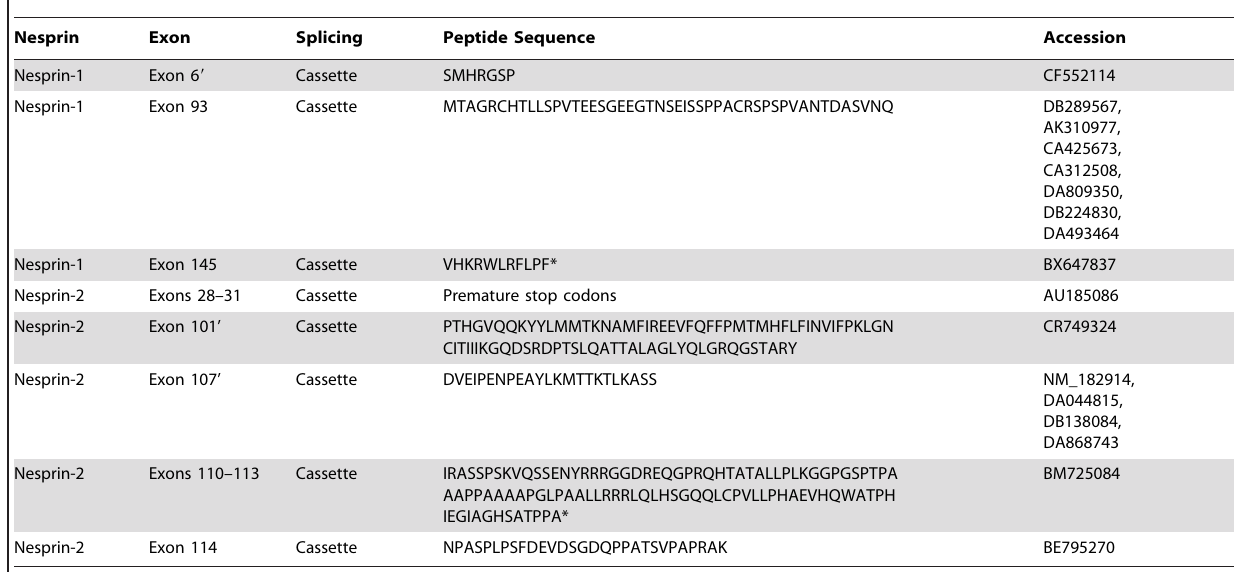
Table 2. Cassette exons identified through online databases.